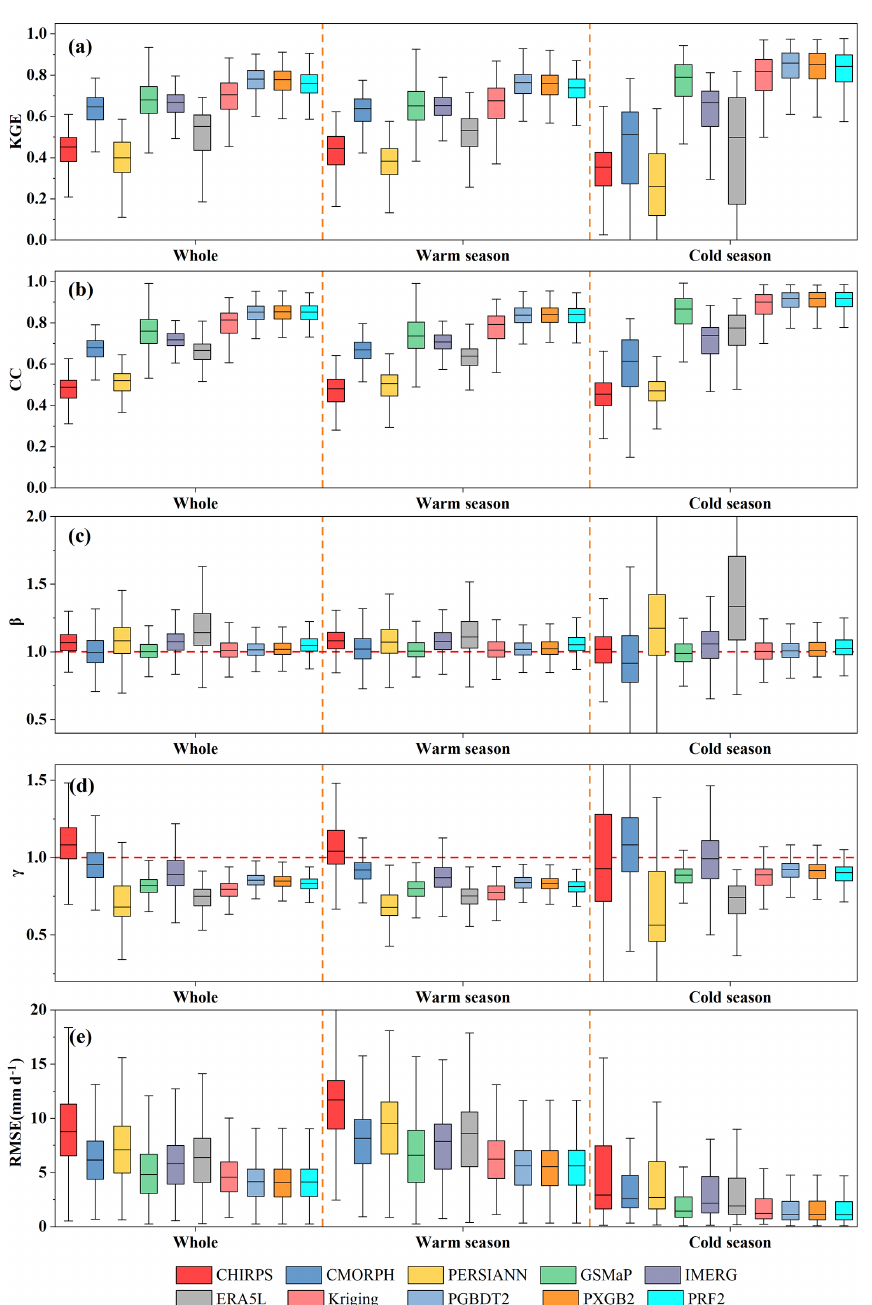
Figure 7. Boxplots of five statistical metrics (KGE (a) , CC (b) , β (c) , γ (d) ), RMSE (d) ) and for 10